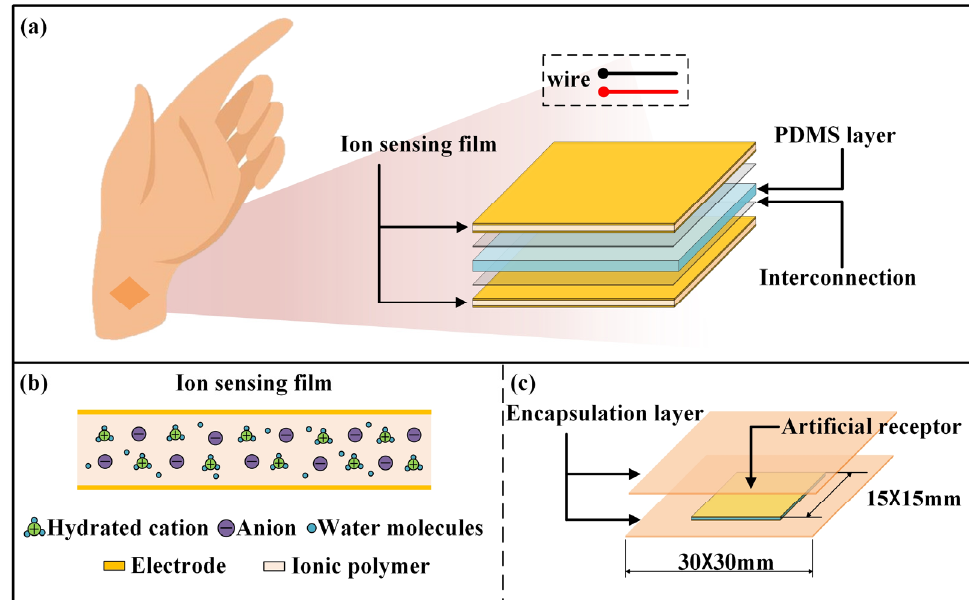
Figure 2. Preparation of bio-inspired artificial receptor. ( a ) Schematic diagram of receptor structure. ( b ) The composition of ion sensing film. ( c ) The encapsulation for receptor.